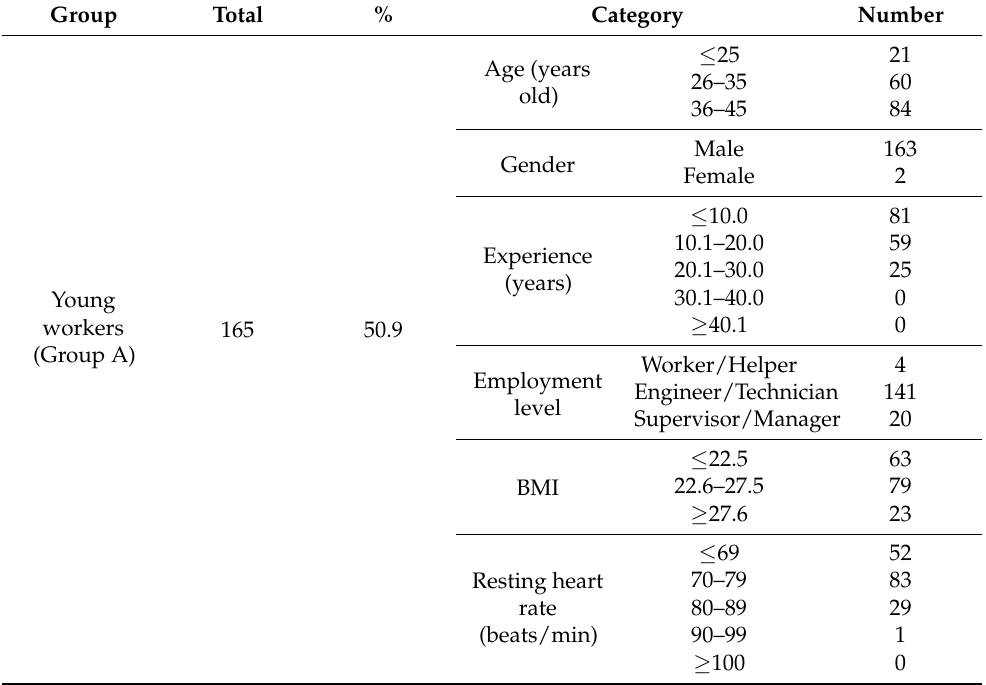
Table 1. The demographic of the participants. Group Total % Category